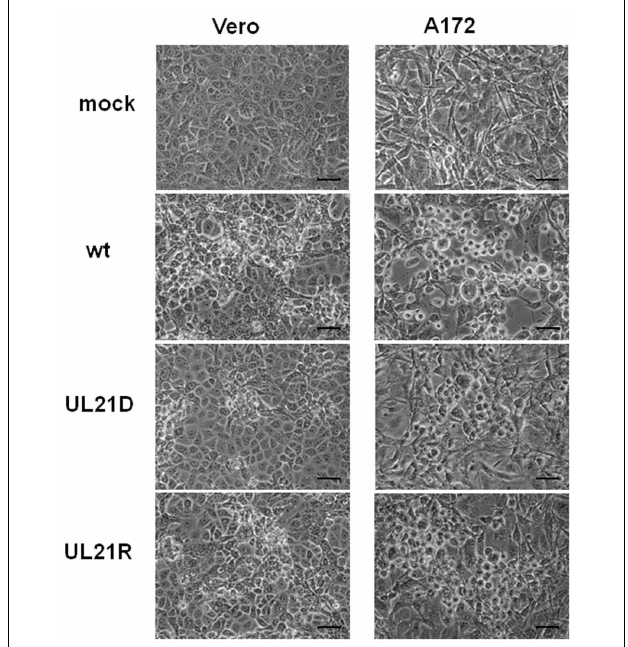
FIGURE 3 | Plaque formation by UL21D inVero andA172 cells. Vero or A172 cells were infected with wild-type HSV-1 (wt), UL21D, or UL21R at an MOI of 0.03.Viral plaques were photographed at 24h post-infection. Bars indicate 50 µ